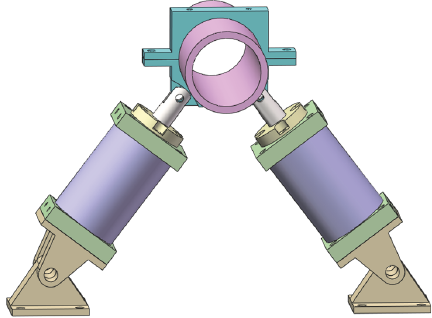
Figure 1: Pipeline damping suppression system.